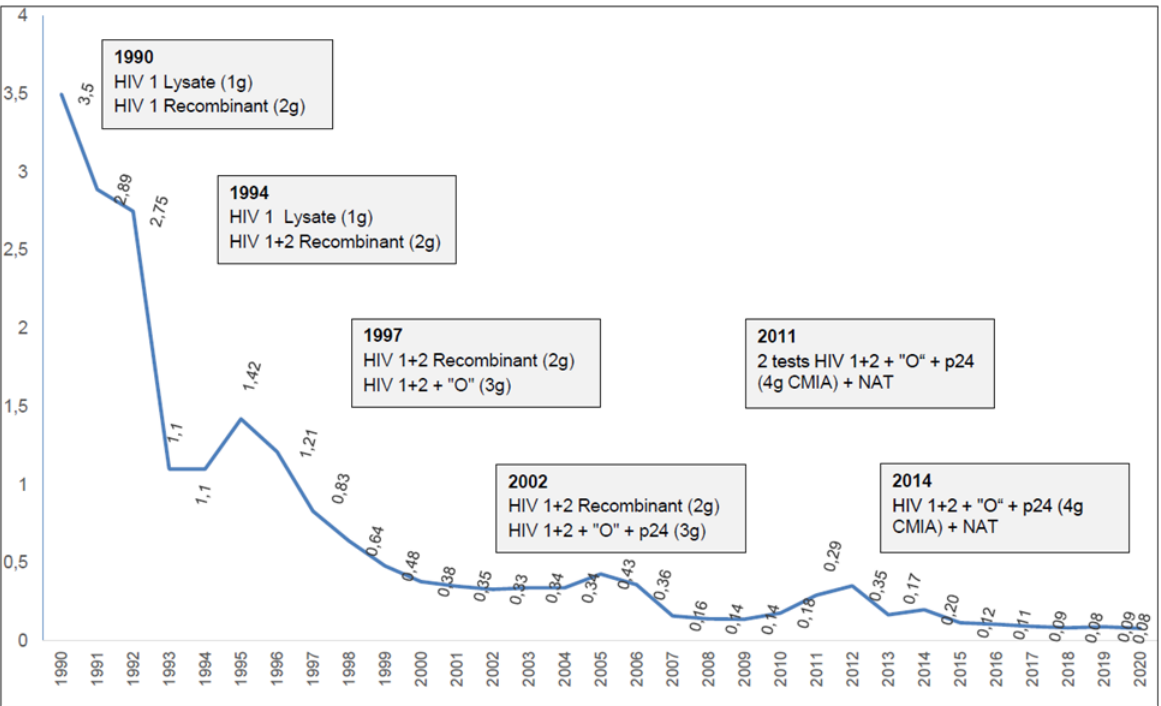
Figure 1. HIV discard rate of different generations of serological kits for blood donor screening tests from 1990 to 2020 and of NAT-HIV from 2011 to 2020 at FPS-HSP (1 g, first generation; 2 g, second generation; 3 g, third generation; 4 g, fourth generation kit; chemiluminescent immunoassay,